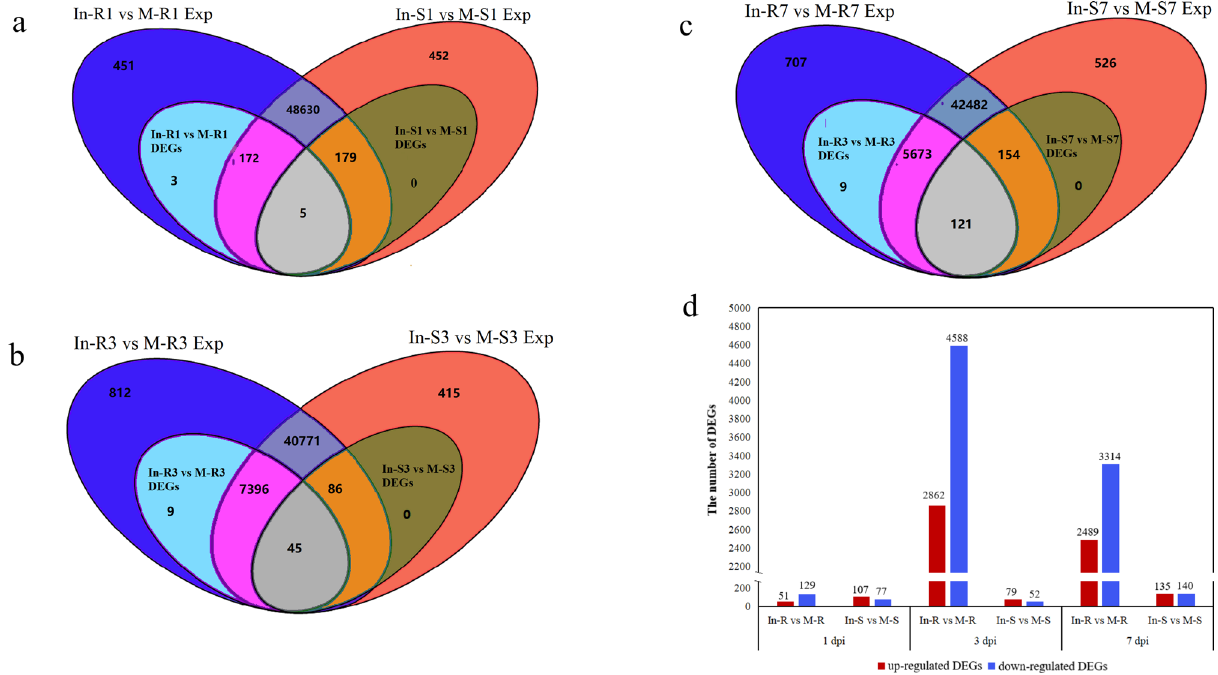
Figure 2. Differentially expressed genes (DEGs) in the resistant and susceptible cultivars inducing by Ralstonia solanacearum infection. Venn diagrams of all expressed genes and DEGs in resistant and susceptible cultivars at 1 ( a ), 3 ( b ), and 7 ( c ) dpi. In-R versus M-R Exp and In-R versus M-R DEGs indicated, compared with mock samples (M-R), the expressed genes and DEGs in the resistant cultivar inducing by R. solanacearum infection (In-R), respectively. In-S versus M-S Exp and In-S versus M-S DEGs indicated, compared with mock samples (M-S), the expressed genes and DEGs in the susceptible cultivar inducing by R. solanacearum infection (In-S), respectively. The number of upregulated and downregulated genes among DEGs in resistant and susceptible cultivars induced by R. solanacearum infection ( d ). Venn diagrams were generated in R (v 2.15.3) with the VennDiagram package (v 1.6.20, https ://cran.r-proje ct.org/web/packa ges/VennD iagra m/index